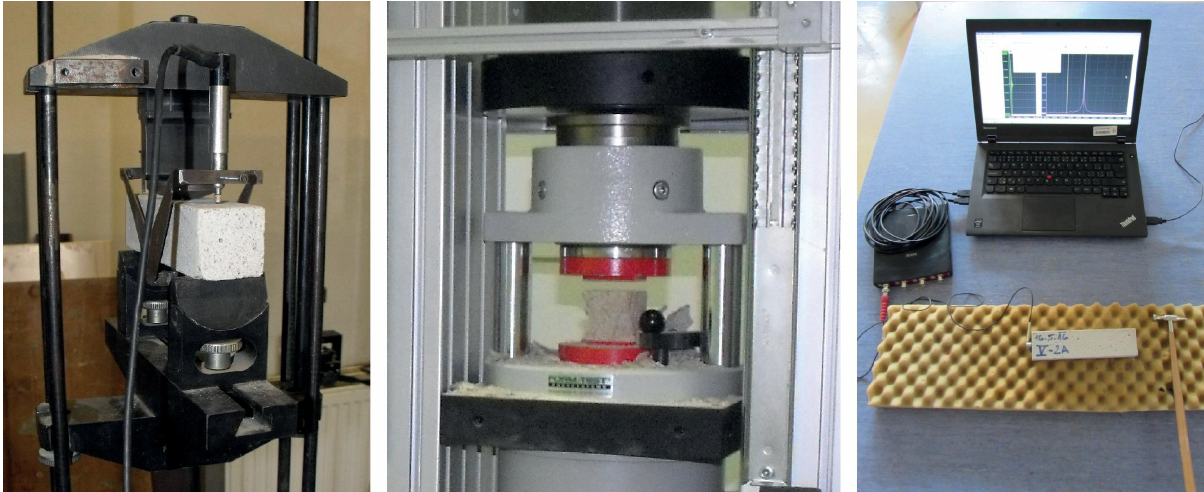
Figure 2. Arrangement of the fracture test (left), compressive strength test (middle) and resonance test (right).